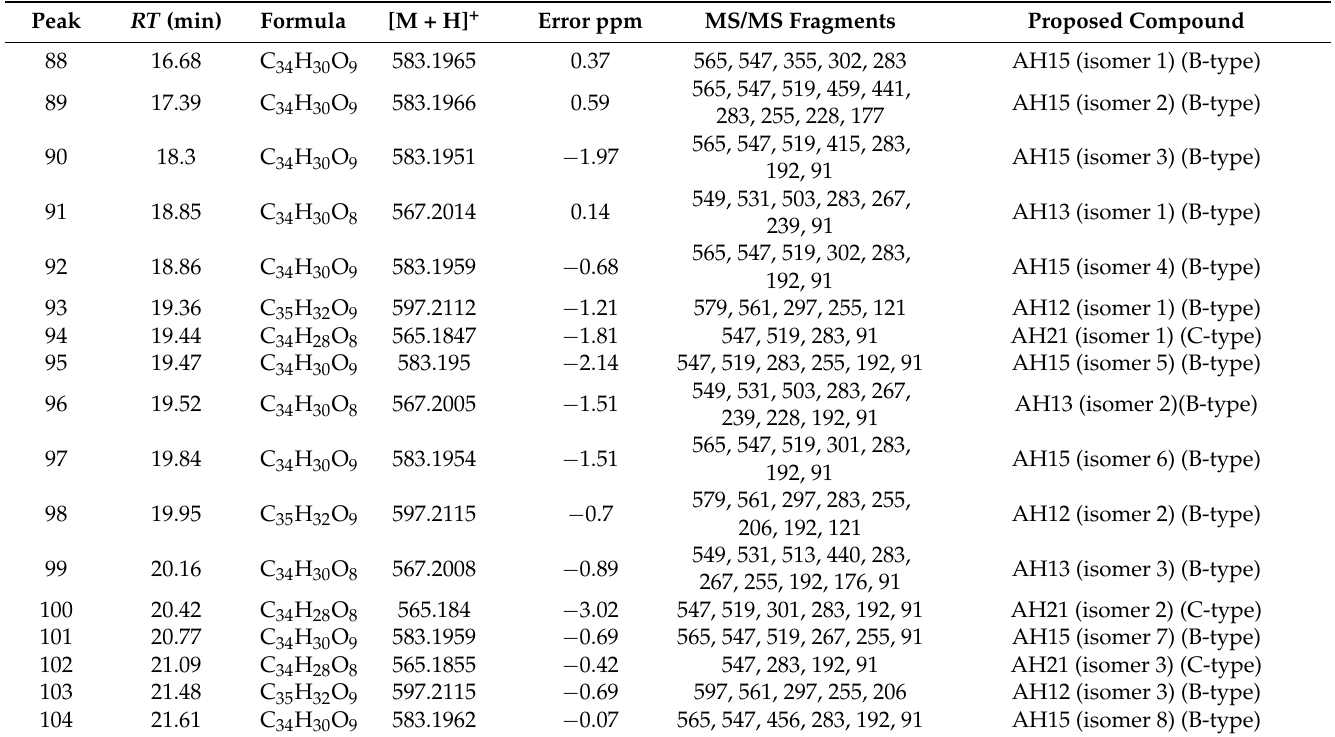
Table 2. Retention time (RT) and mass spectral data of the compounds characterized in agarwood extract by UPLC–ESI-QTOF-MS and MS/MS in positive mode (bi-2-(2-phenylethyl)-chromones and